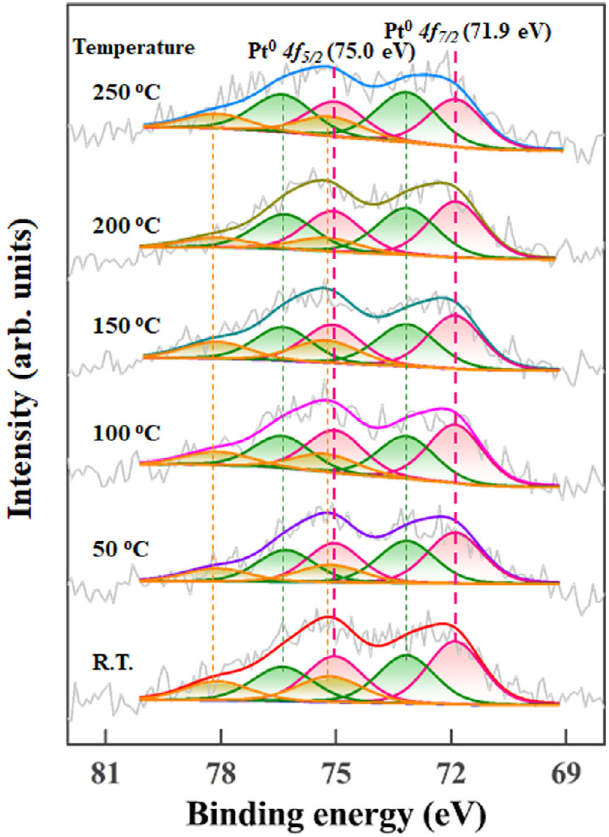
Fig. 5 In situ electronic structure characterization. In situ XPS Pt 4f spectra of Pt/CNT-600 under the reaction atmosphere at elevated